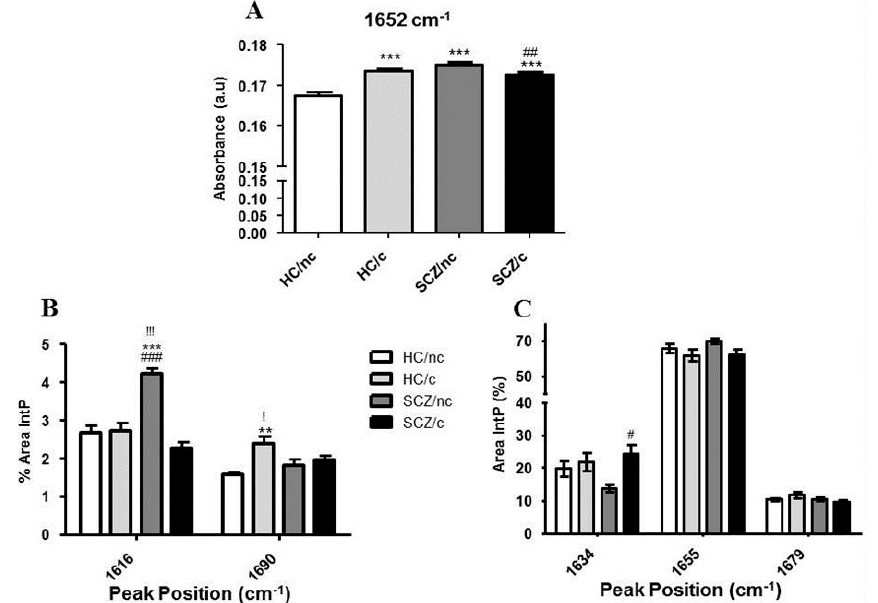
Figure 5. Major peak amplitudes related to the protein signature in ON cells from healthy controls non-cannabis users (HC/nc); healthy controls cannabis users (HC/c); schizophrenic patients non-cannabis users (SCZ/nc) and schizophrenic patients cannabis users (SCZ/c). ( A ) Peak amplitudes for the Amide I peak (1652 cm − 1 ). ( B , C ) Amide I area FTIR spectra deconvolution expressed as the percentage of the integrated area (%) of the protein secondary structures related to their centred peak positions. (B) Side chains/cross β -sheet (1616 cm − 1 ), and antiparallel β -sheet (1690 cm − 1 ). ( C ) β -sheet/unordered (1634 cm − 1 ), α -helix (1655 cm − 1 ), and turns & loops (1679 cm − 1 ). The data are expressed as means ± S.E.M. * p < 0.05; ** p < 0.01; *** p < 0.001 vs. HC/nc. ! p < 0.05; !! p < 0.01; !!! p < 0.001 HC/c vs SCZ/nc.